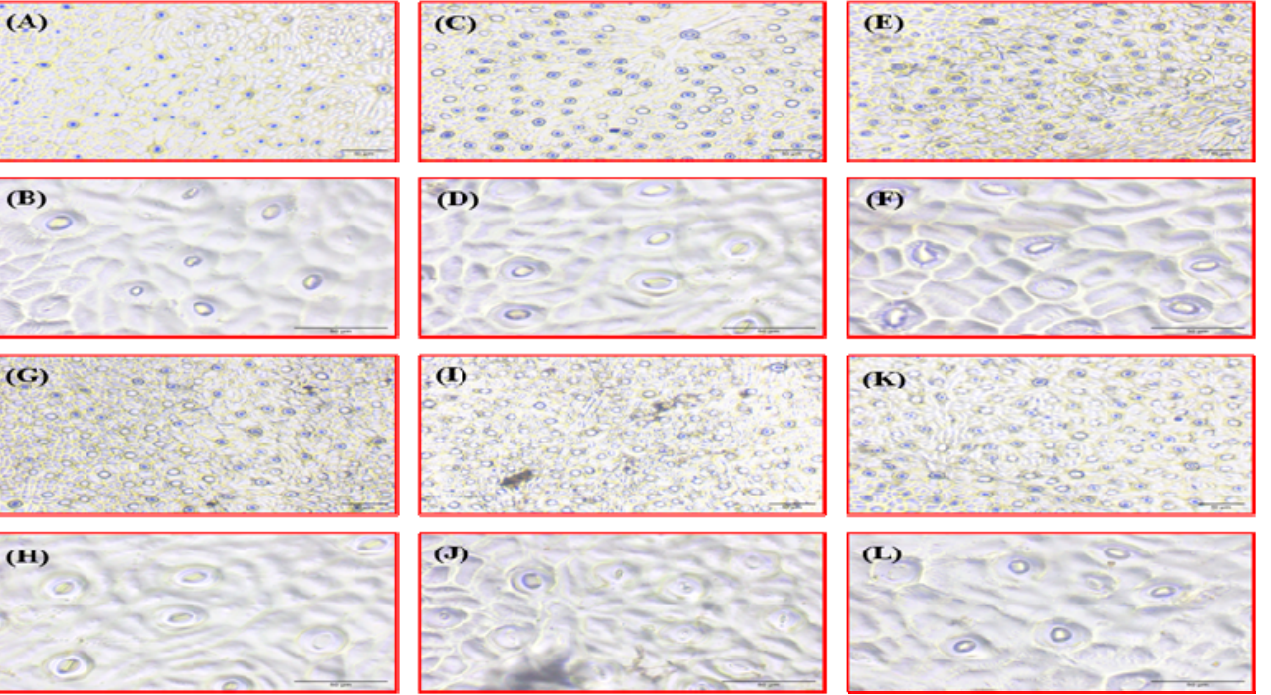
Figure 2. Comparison of stomatal distribution and aperture size between resistant and susceptible genotypes of Citrus spp. Immune: Kagzi Kalan lemon, ( A ) 10× and ( B ) 40×; highly susceptible: ALC-35, ( C ) 10× and ( D ) 40×; moderately susceptible: Konkan Seedless lemon, ( E ) 10× and ( F ) 40×; susceptible genotype: Pusa Udit lime, ( G ) 10× and ( H ) 40×; moderately resistant genotype: Redblush grapefruit, ( I ) 10× and ( J ) 40×; highly resistant genotype: Marsh seedless grapefruit, ( K ) 10× and ( L ) 40×.